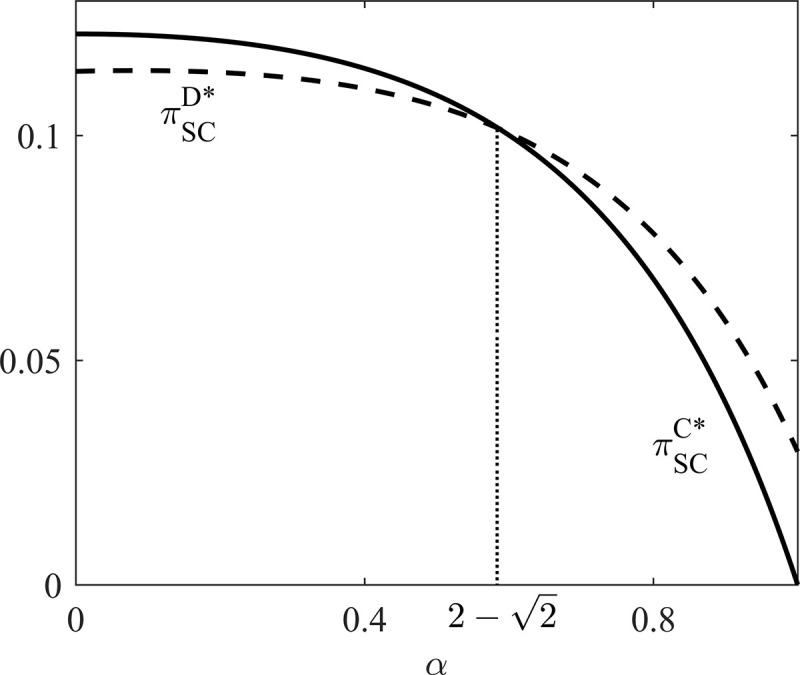
Profit comparison between D and C scenarios.